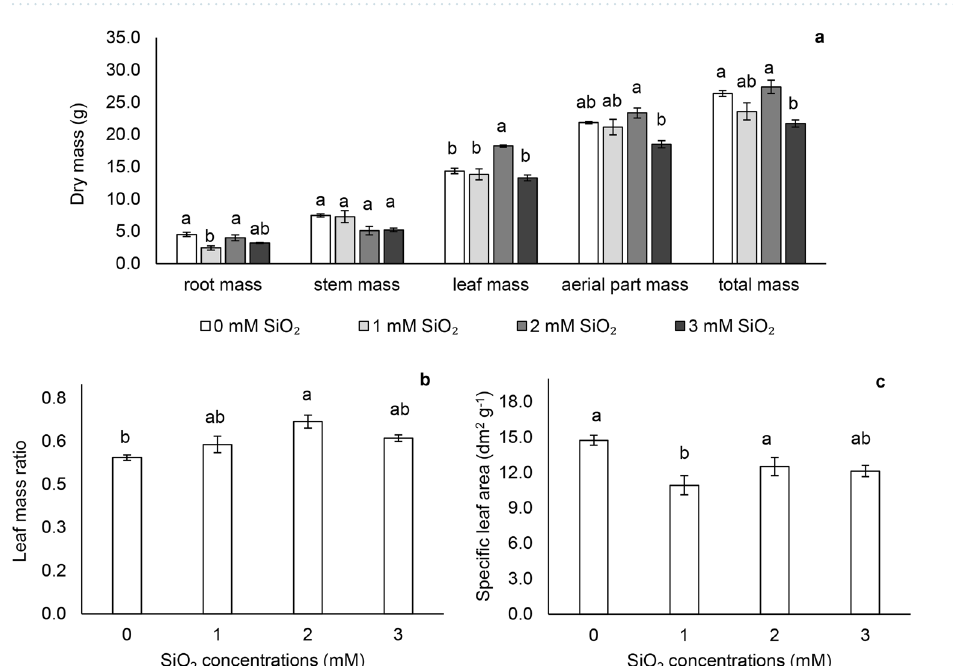
Figure 6. Biomass. ( a ) Dry masses of roots (p < 0.01), stems (p < 0.03), leaves (p < 0.01), aerial part (p < 0.01) and total plant (p < 0.01); ( b ) leaf mass ratio (p < 0.01); ( c ) specific leaf area (p < 0.01) in Passiflora incarnata subjected to SiO 2 variations. Values corresponding to the averages ±